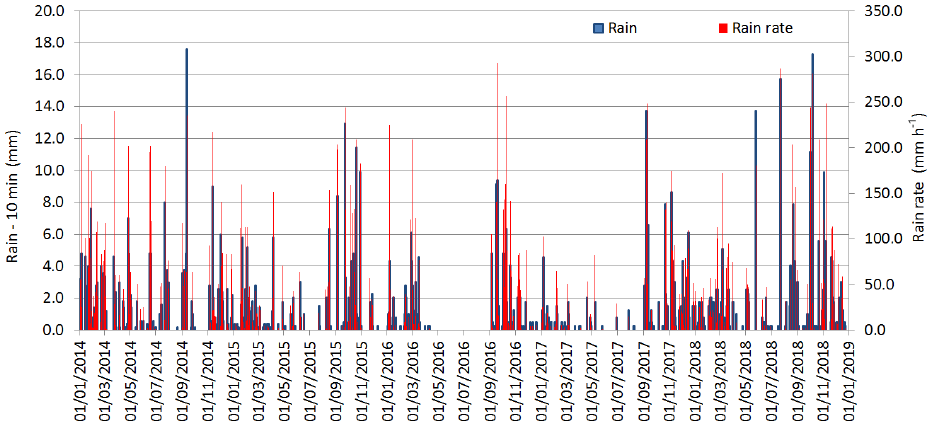
Figure 15. Rain amount (10min) and rain rate time series data showing daily, seasonal and annual variation patterns in the Denza station during 2014–2018.